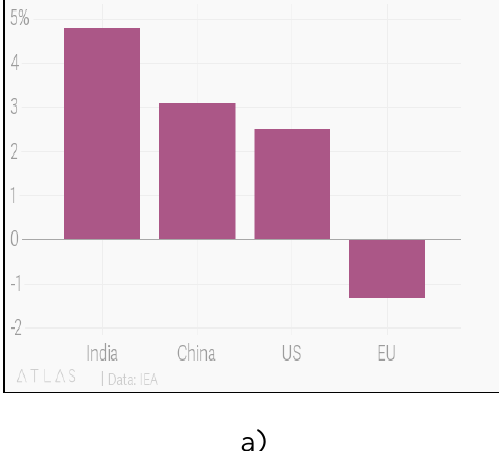
emissions fall by 2